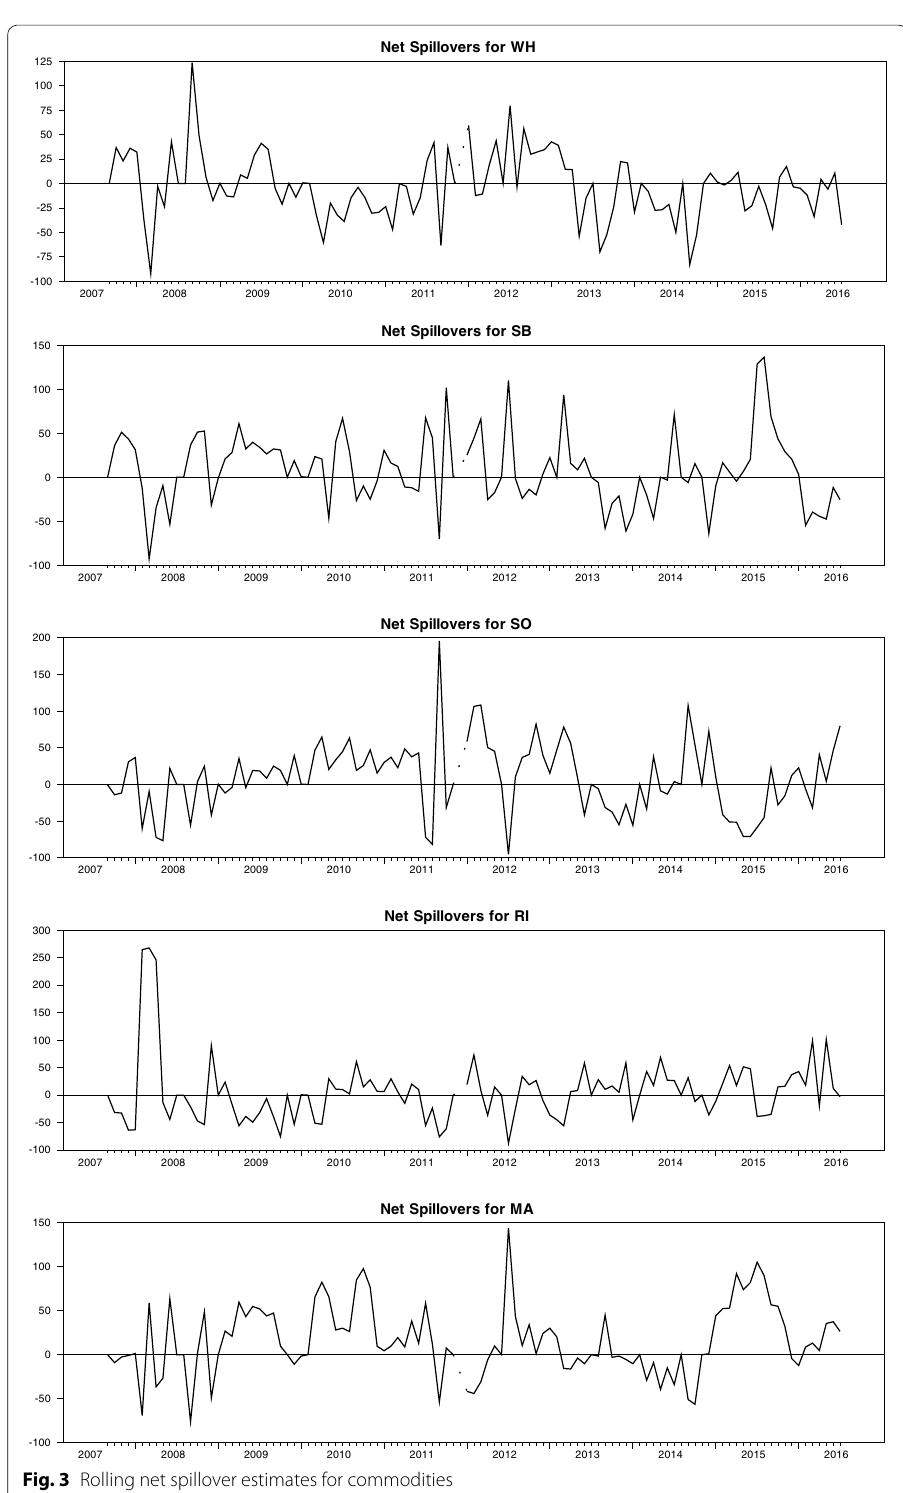
Fig. 3 Rolling net spillover estimates for